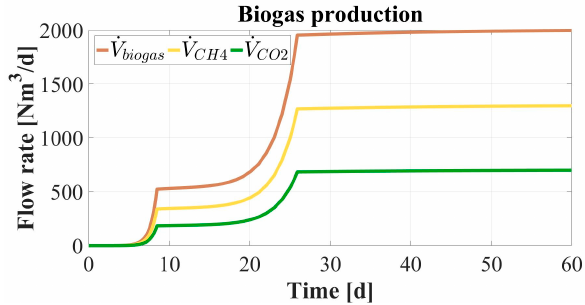
Figure 3. Flow rate of biogas, CO 2 and CH 4 . Table 8. Components concentrations under steady-state conditions, after 60 days .